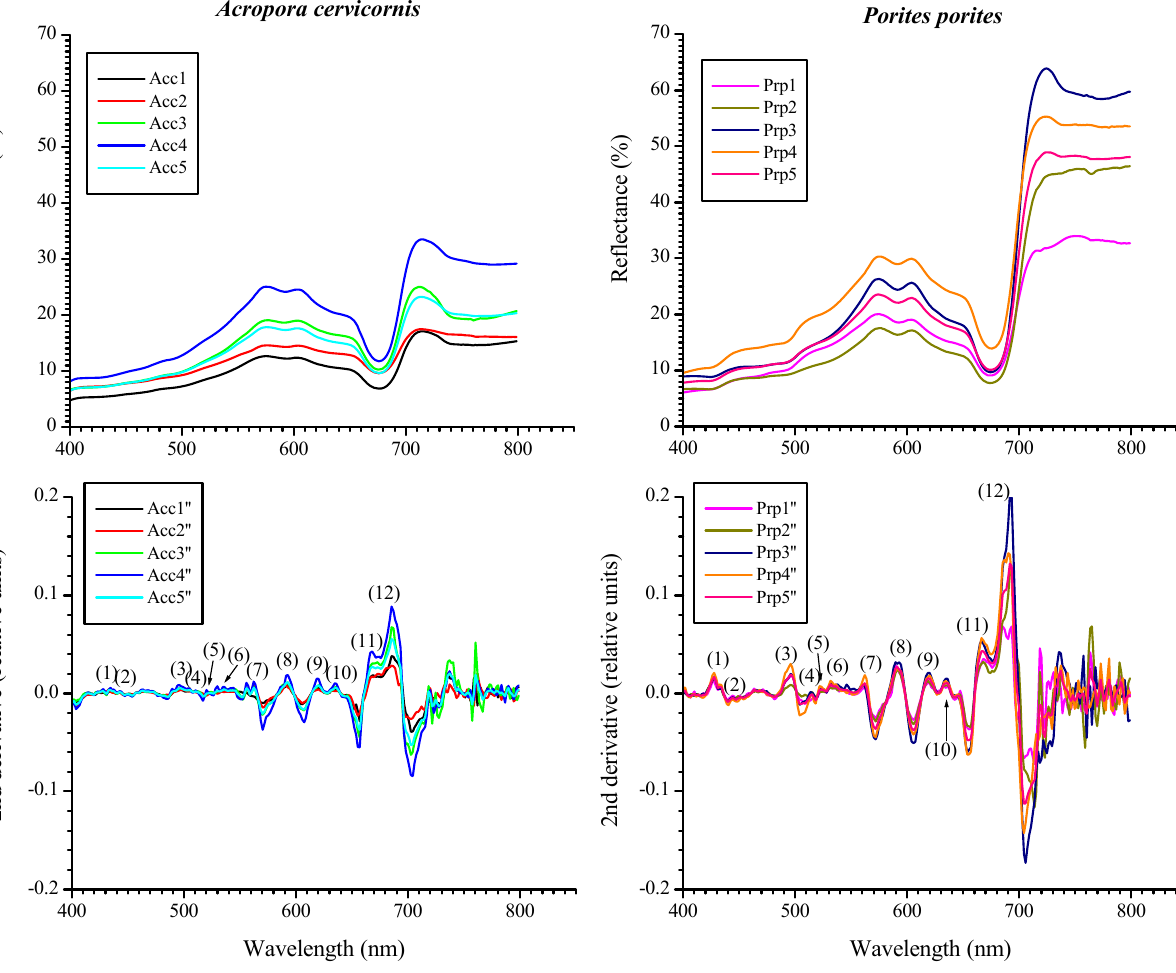
Figure 4. Reflectance curves for A. cervicornis and P. porites (n = 5) with their respective 2 nd derivative. The numbers in parenthesis in the derivative graphs represent peaks at specific wavelengths (nm): (1) 427, (2) 442, (3) 495, (4), 514, (5) 522, (6) 530, (7) 563, (8) 589, (9) 618, (10) 634, (11) 665 and (12) 685. The heights of nine out of twelve peaks were significantly different between species (peaks at 514, 522 and 563 nm were not significantly different at α ≤